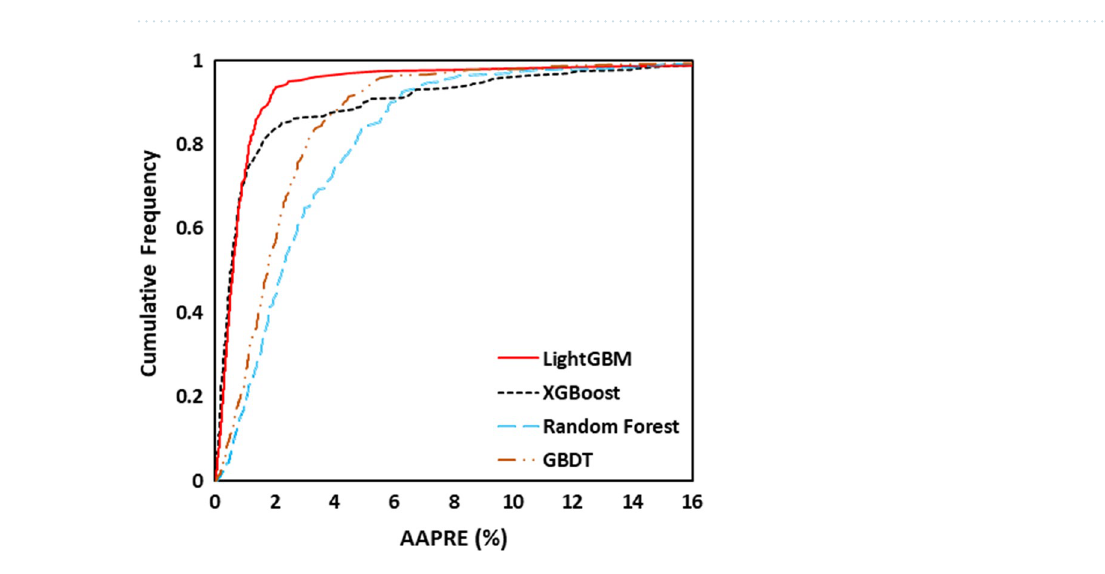
Figure 5. The cumulative frequency diagram of the proposed machine learning